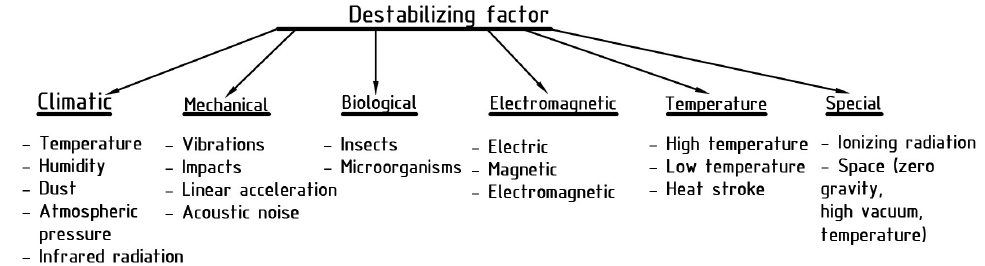
Figure 2. Classification of destabilizing factors.